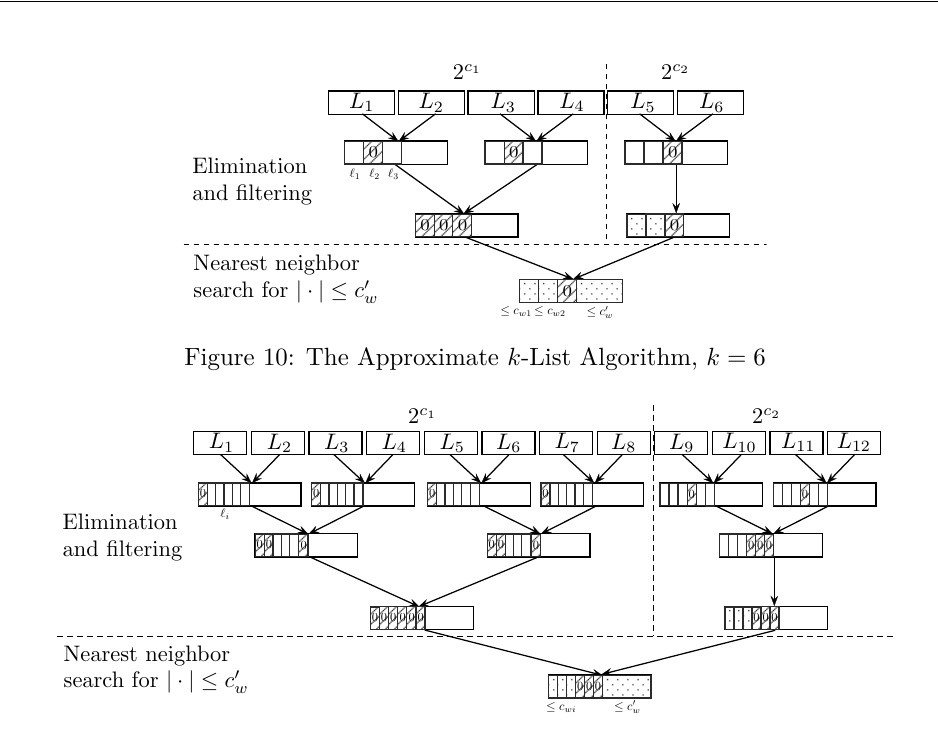
Figure 11: The Approximate k -List Algorithm, k = 12